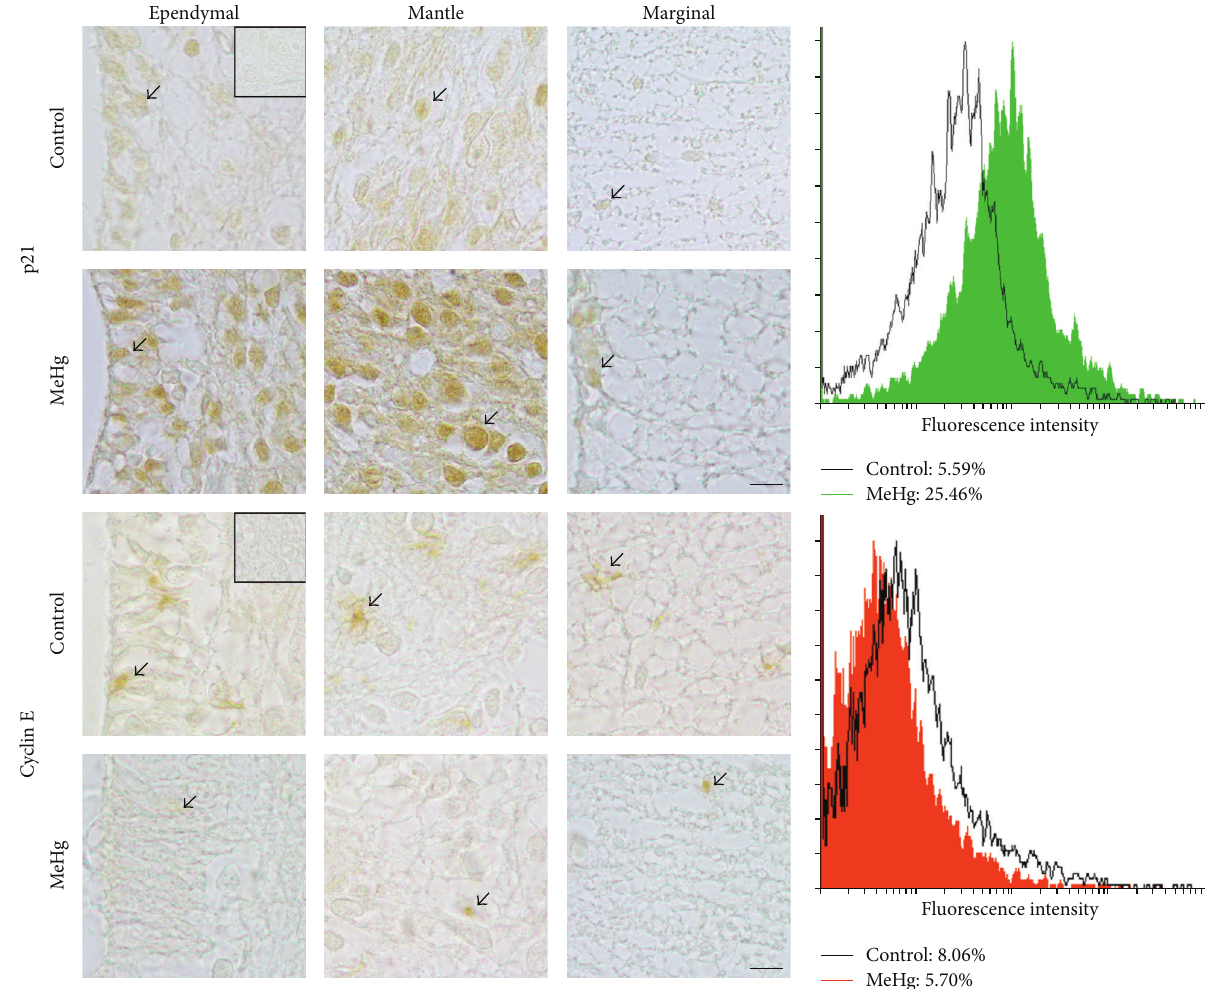
Figure 4: Cell cycle proteins analyzed by immunohistochemistry and flow cytometry. Immunohistochemistry revealed p21 and cyclin E- positive cells (arrows) in the control and MeHg-treated embryos. The square in the ependymal control embryos represents the negative control of immunohistochemical reaction. The graphs display the expression profile and relative frequency of positive cells of p21 and cyclin E in the spinal cord of the control and MeHg-treated embryos. For each treatment 1,800 events were analyzed per antibody. Scale bars: 10 𝜇 m.